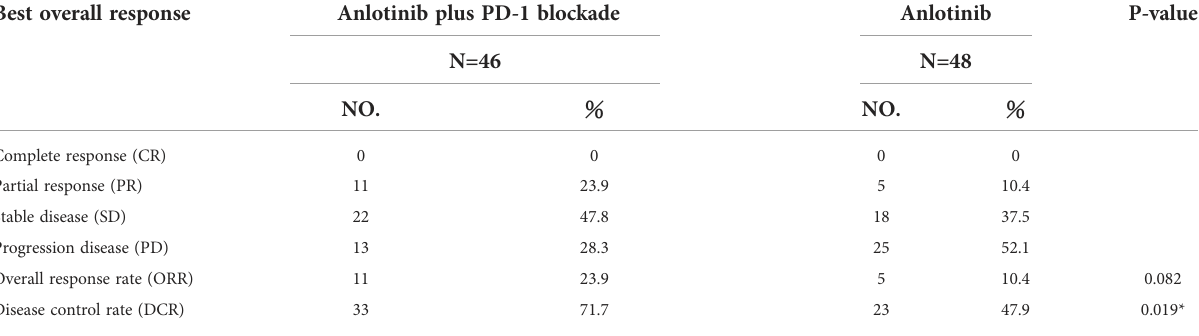
TABLE 3 Analysis of ef fi